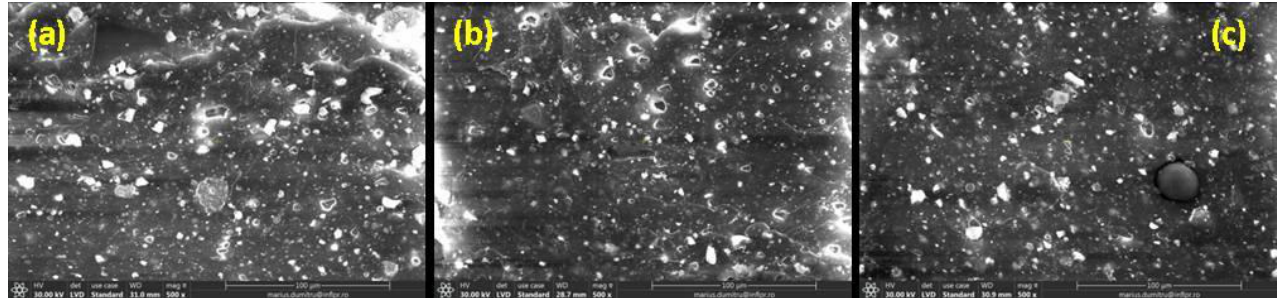
Figure 8. SEM micrographs of non-irradiated NR-C sample ( a ) and irradiated at 150 kGy ( b ) and 450 kGy ( c ) (magnification of 500).